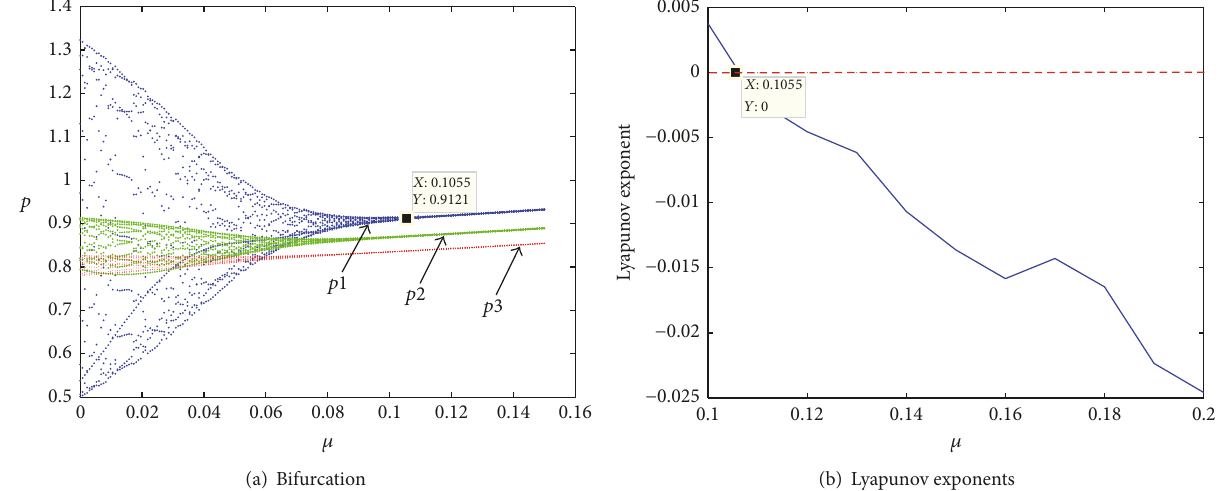
Figure 8: The influence of 𝜇 on the system when 𝜏 1 = 0.58 , 𝜏 2 = 0.45